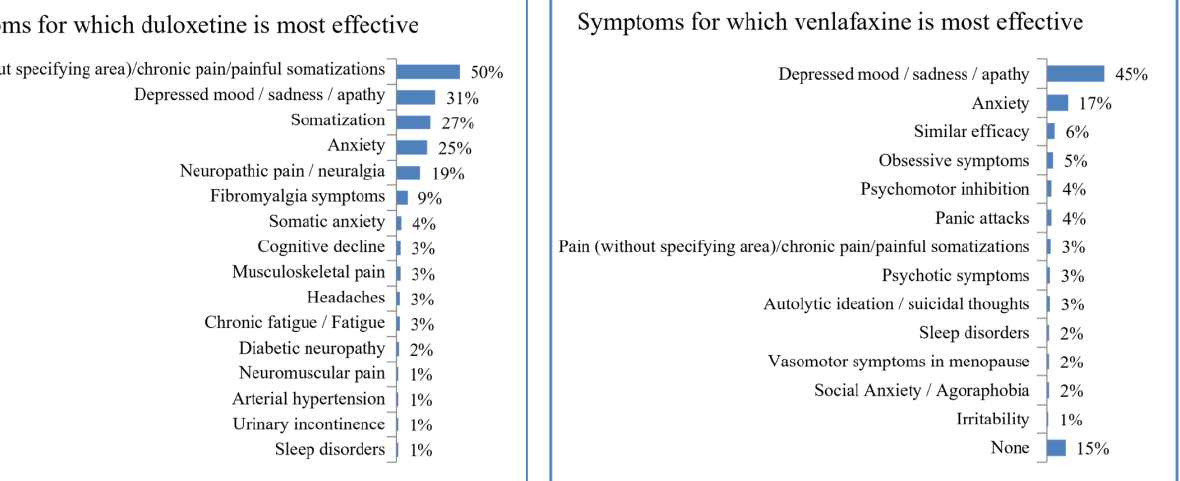
Figure 2. Comparison between duloxetine and venlafaxine and symptoms for which they are more effective.